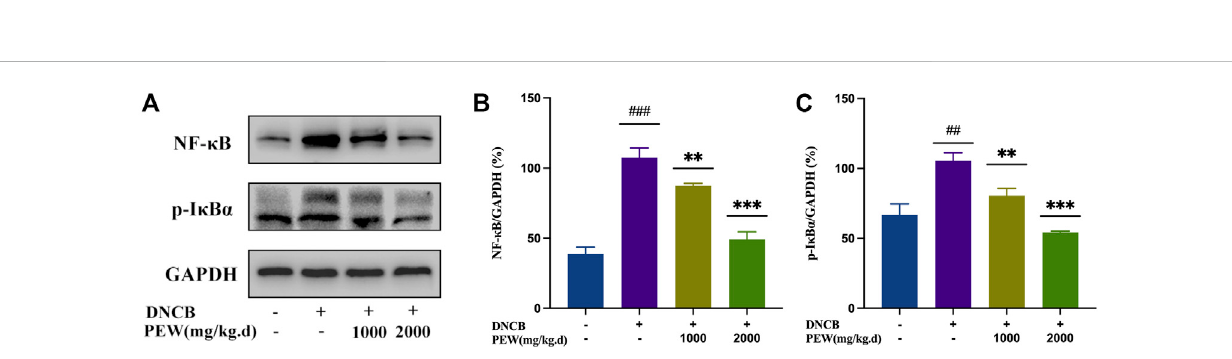
FIGURE 7 PEW inhibited the NF- κ B signaling pathway. (A) . Representative images of Western Blotting assays of NF- κ B and p-I κ B α . (B) . Expression of NF- κ B relativetoGAPDH( n =3/group). (C) .Expressionofp-I κ B α relativetoGAPDH( n =3/group).Thedatawerepresentedasmeans±SD.## p < 0.01,### p